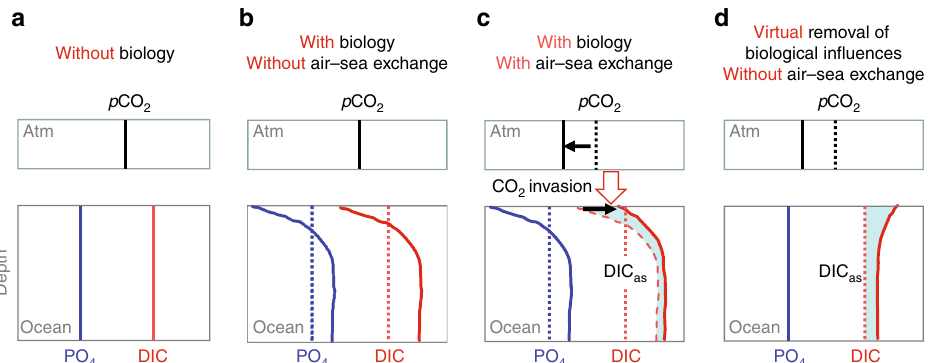
Fig. 1 Concepts to distinguish DIC as . For simplicity, only CO 2 invasion associated with organic matter cycling is considered. In the ocean box, vertical solid and dashed lines ( a – d ) represent mean PO 4 (blue) and DIC (red) in an abiotic ocean ( a ). Biology redistributes DIC and PO 4 following Red fi eld stoichiometry (curves; b ). This decreases surface-ocean DIC and p CO 2 , and hence causes air-to-sea CO 2 transfer ( c ). Through mixing and ocean circulation, CO 2 invasion raises water-column DIC, i.e., shifting dashed curve (equals the red-solid curve in b ) to red-solid curve ( c ). The shaded region in c represents air – sea exchange DIC as signatures. After removing carbon redistribution by biology based on PO 4 -related curvature of the pro fi les ( b ), DIC as can be revealed by the shaded region in